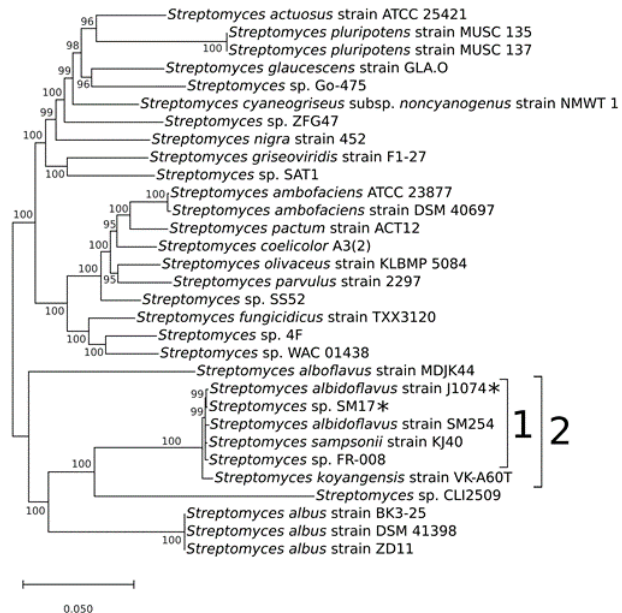
Figure 1. Phylogenetic tree of the concatenated sequences of the 16S rRNA and the housekeeping genes atpD , gyrB , recA , rpoB , and trpB , from the Streptomyces sp. SM17 together with 30 Streptomyces isolates for which complete genome sequences were available in the GenBank database. Analysis was performed using MrBayes, with a posterior probability cut-off of 95%. 1) albidoflavus phylogroup. 2) Clade including the neighbour isolate Streptomyces koyangensis strain VK-A60T. The strains SM17 and J1074 are indicated with asterisks.